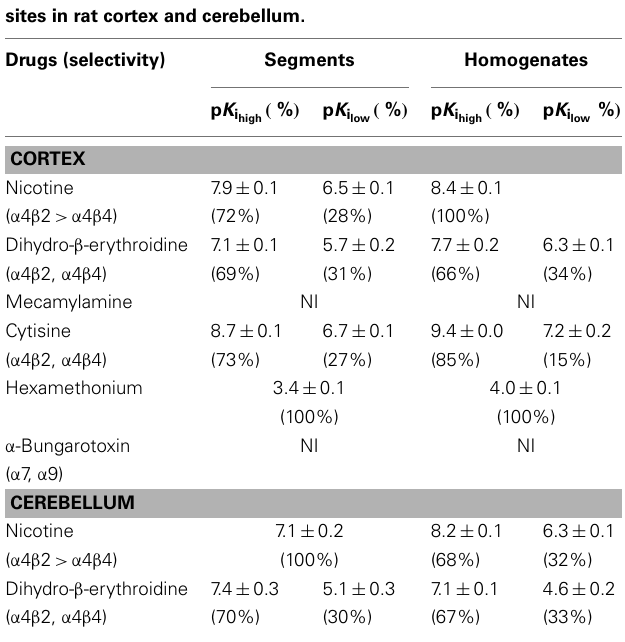
FIGURE 3 | Competition curves for various dugs at [ 3 H]-epibatidine binding sites in intact segments and homogenates of rat cerebral cortex (A,B) and rat cerebellum (C,D). Intact segments (A,C) were incubated with 400pM [ 3 H]-epibatidine for 28h at 4˚C. Homogenates